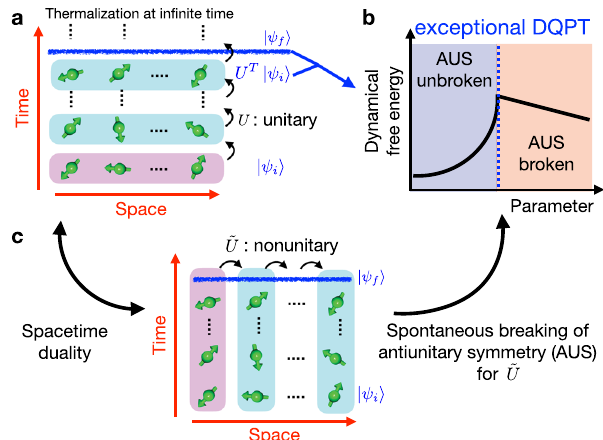
Fig. 1 Schematic of the exceptional dynamical quantum phase transition (DQPT). a Periodically driven unitary dynamics described by an operator U . While our nonintegrable system thermalizes for local observables at in fi nite times, we here discuss the phase transitions occurring at fi nite times. b Example of the exceptional DQPT. Dynamical free energy, which is obtained from the overlap between the time-evolved state U T j ψ i i and the reference state j ψ f i , has a divergent derivative at some critical parameter approached from the antiunitary-symmetry (AUS) unbroken phase. c Origin of the exceptional DQPT as the spontaneous AUS breaking. Using the spacetime duality, we fi nd a hidden nonunitary transfer operator ~ U that propagates in space direction. We uncover that the exceptional DQPTs arise when the AUS for ~ U is spontaneously